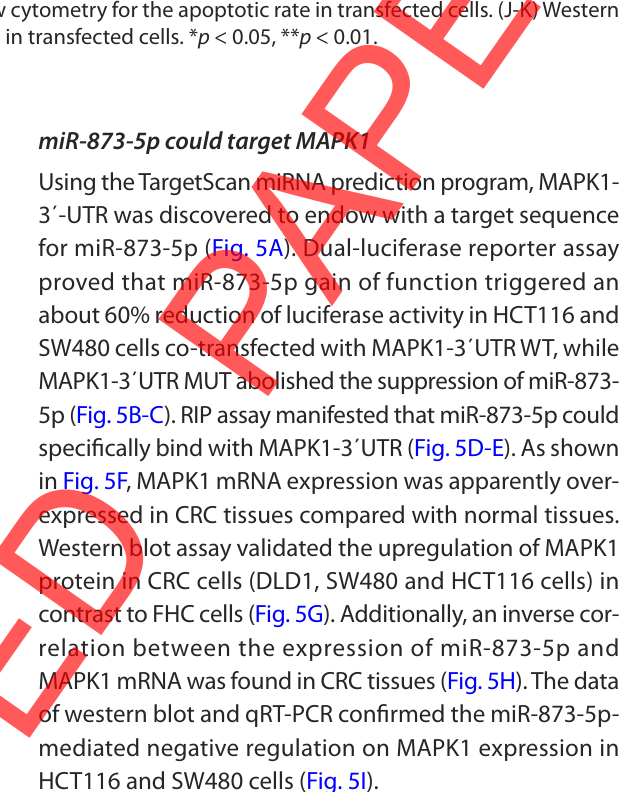
Fig. 4 MiR-873-5p inhibition mitigated the circ_0067835 deficiency-induced the decreased proliferative and metastatic abilities of CRC cells. (A) qRT-PCR assay for the relative expression of miR-873-5p in HCT116 and SW480 cells transfected with anti-miR-NC or anti-miR-873-5p. (B-K) HCT116 and SW480 cells were transfected with si-NC, si-circ_0067835#1, si-circ_0067835#1+anti-miR-NC or si-circ_0067835#1+anti-miR-873-5p. (B-C) qRT-PCR assay for the relative expression of miR-873-5p in transfected cells. (D-E) CCK- 8 assay for the cell viability of transfected cells. (F) Colony formation assay for the clonogenicity of transfected cells. (G-H) Transwell assay for the migration and invasion of transfected cells. (I) Flow cytometry for the apoptotic rate in transfected cells. (J-K) Western blot assay for the levels of p-PI3K/PI3K and p-AKT/AKT proteins in transfected cells. * p < 0.05, ** p <